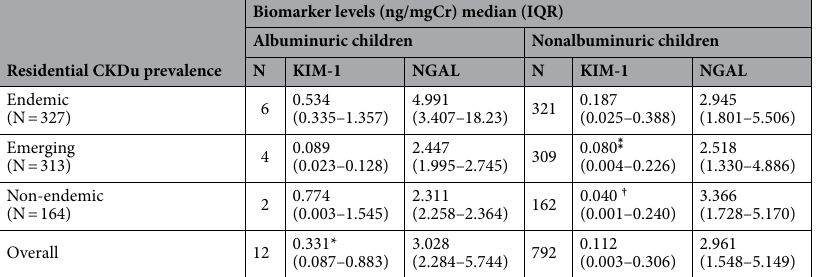
Table 6. Biomarker distribution of children with and without albuminuria. Albuminuria was defined as urinary ACR ≥ 30 mg/g. Statistical comparison of biomarkers in nonalbuminuric children among the three prevalence categories is expressed as implied by Kruskal–Wallis test followed by Dunn’s multiple comparison test. Comparison of overall biomarker levels between albuminuric and nonalbuminuric groups is given according to Mann–Whitney U test. ⁑ Significant compared to emerging group (p = 0.0002), † significant compared to non-endemic group (p = 0.0001), *significant compared to the nonalbuminuric group (p = 0.032). KIM-1 kidney injury molecule-1, NGAL neutrophil gelatinase associated lipocalin, ACR albumin creatinine